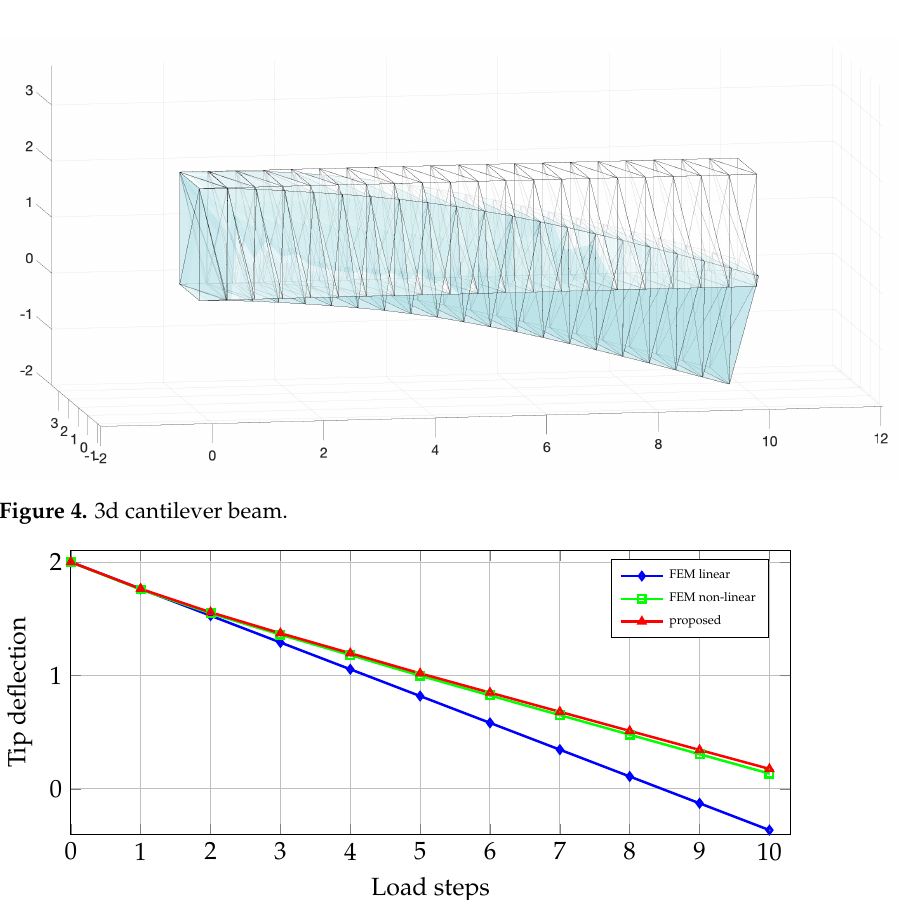
Figure 5. The deflection of the geometrically nonlinear case of a cantilever beam subjected to a regular distributed load calculated using finite element method with tetrahedral elements (FEM-tet) and the proposed